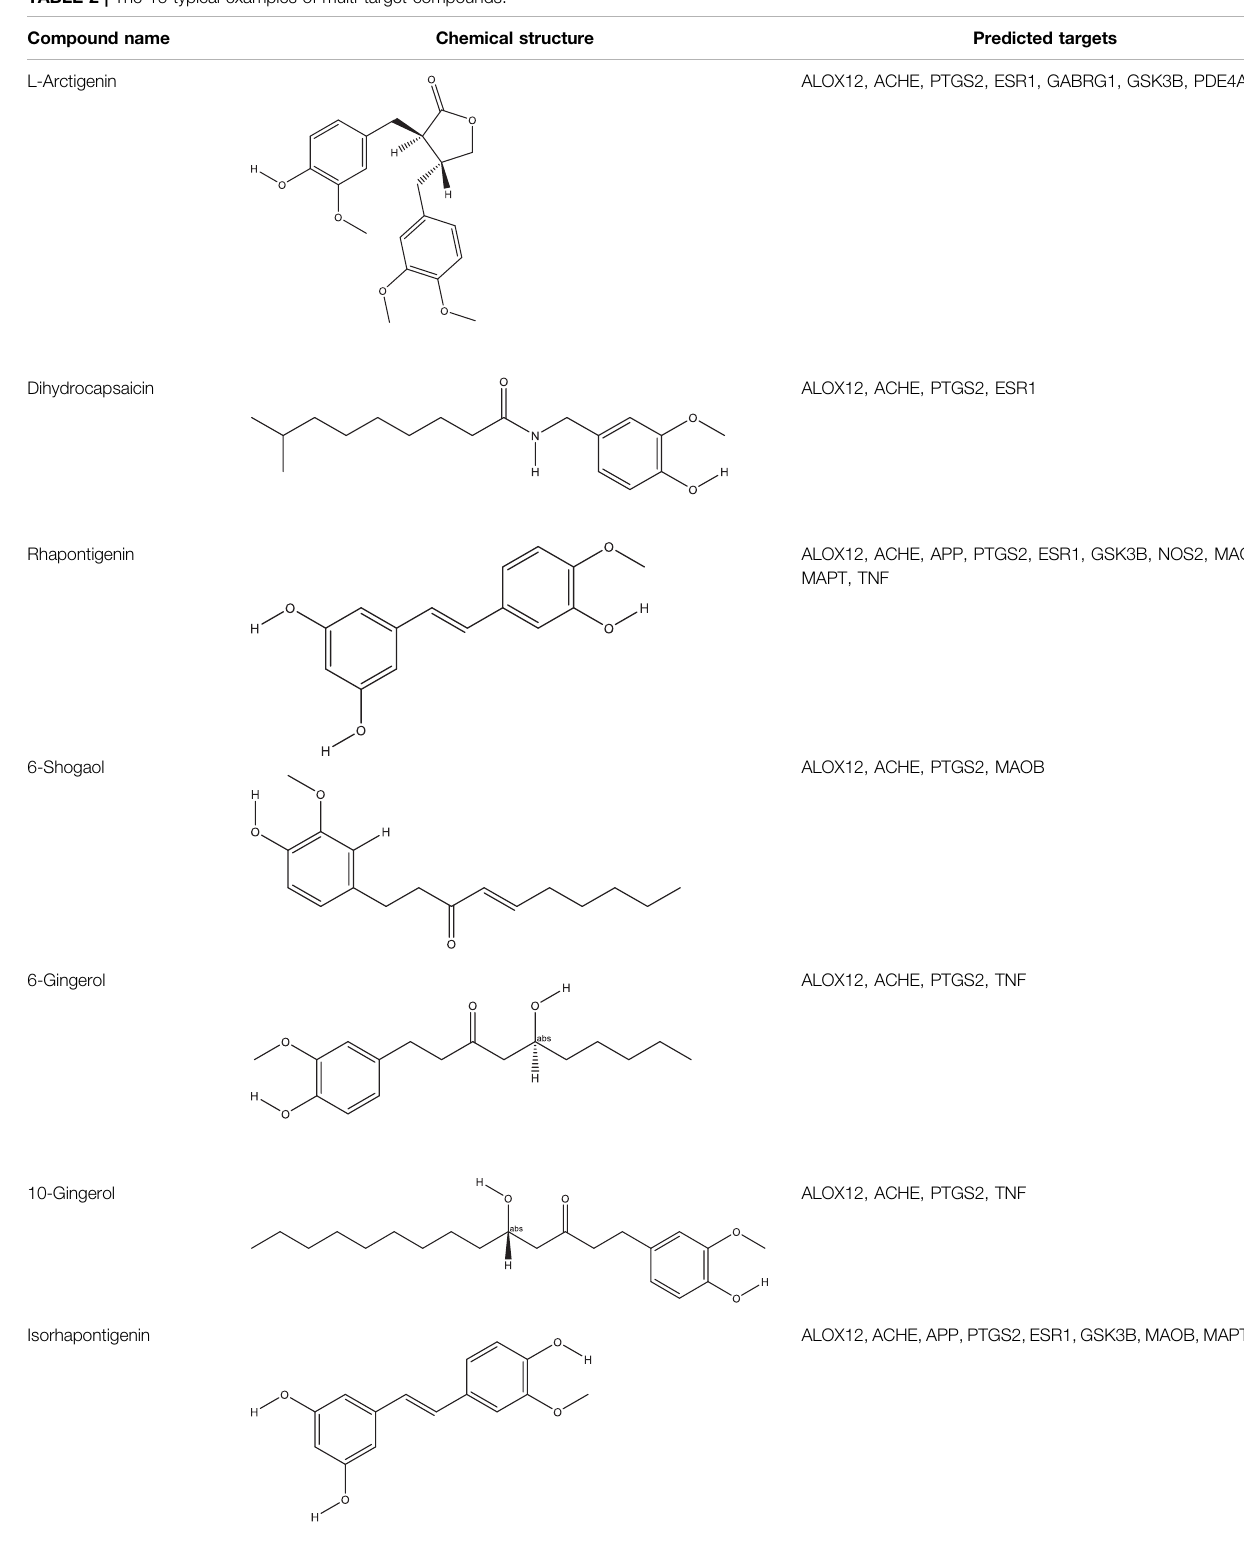
TABLE 2 | The 16 typical examples of multi-target